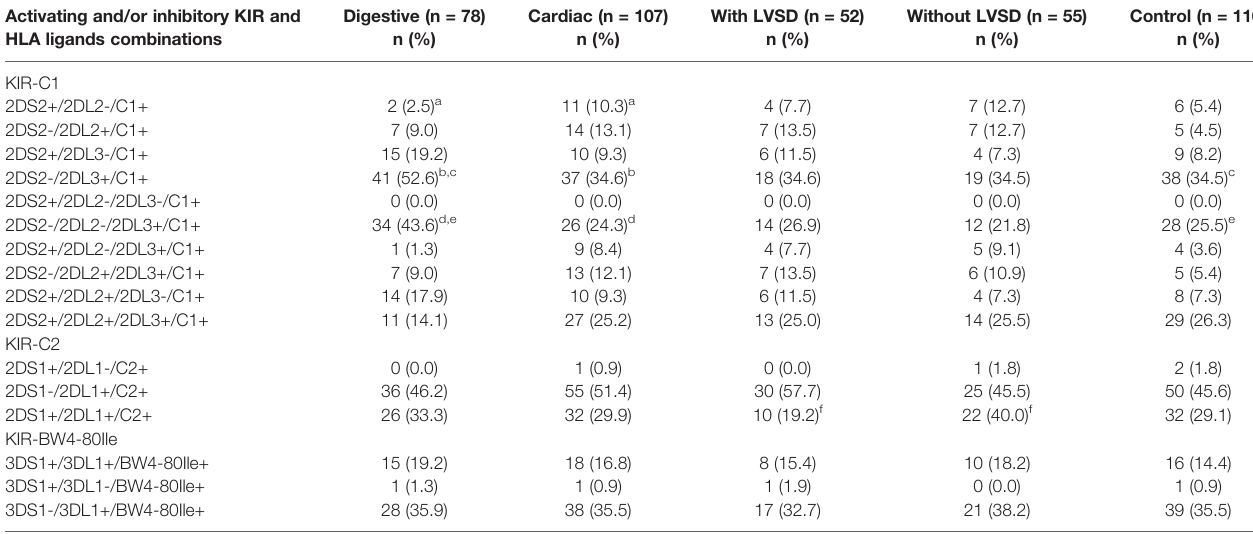
TABLE 6 | Distribution of activating KIR plus inhibitory KIR and their respective ligands in patients with the digestive or cardiac forms of chronic Chagas disease, in patients with LVSD and without LVSD and in control individuals. Activating and/or inhibitory KIR and Digestive (n = 78) Cardiac (n = HLA ligands combinations